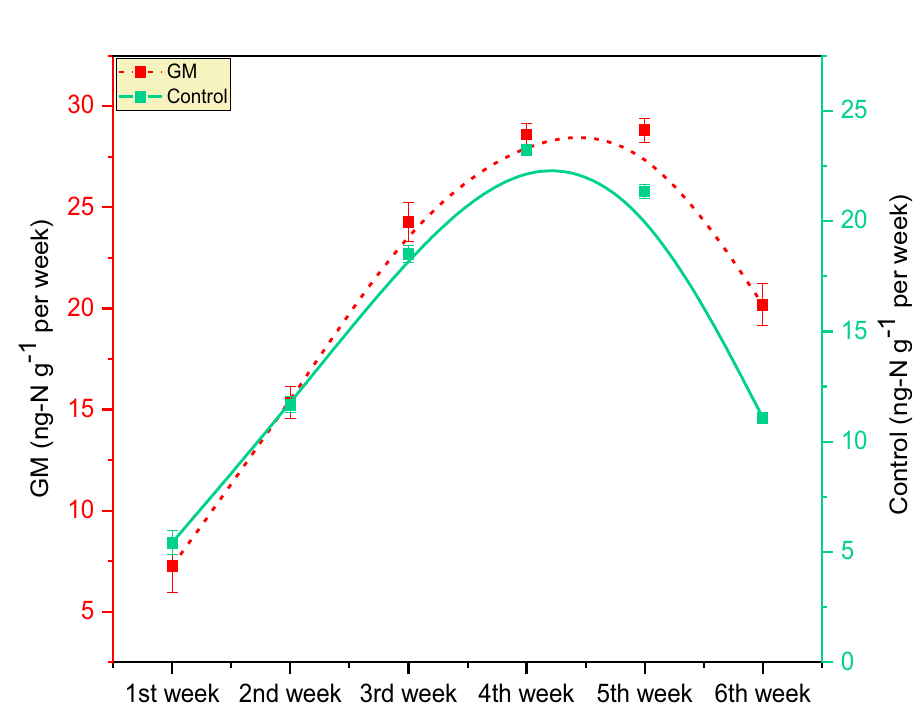
Figure 4. Temporal variation in denitrification rates (ng-Ng −1 per week) in casts from goat manure (GM) with and without A. caliginosa